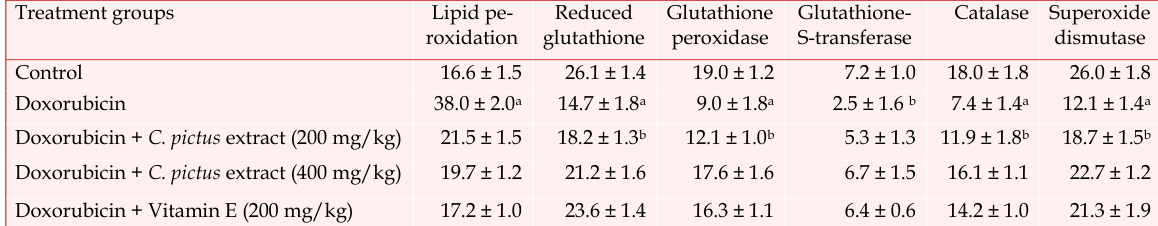
Shows the level of lipid peroxides, glutathione and anti-oxidant enzymes in the